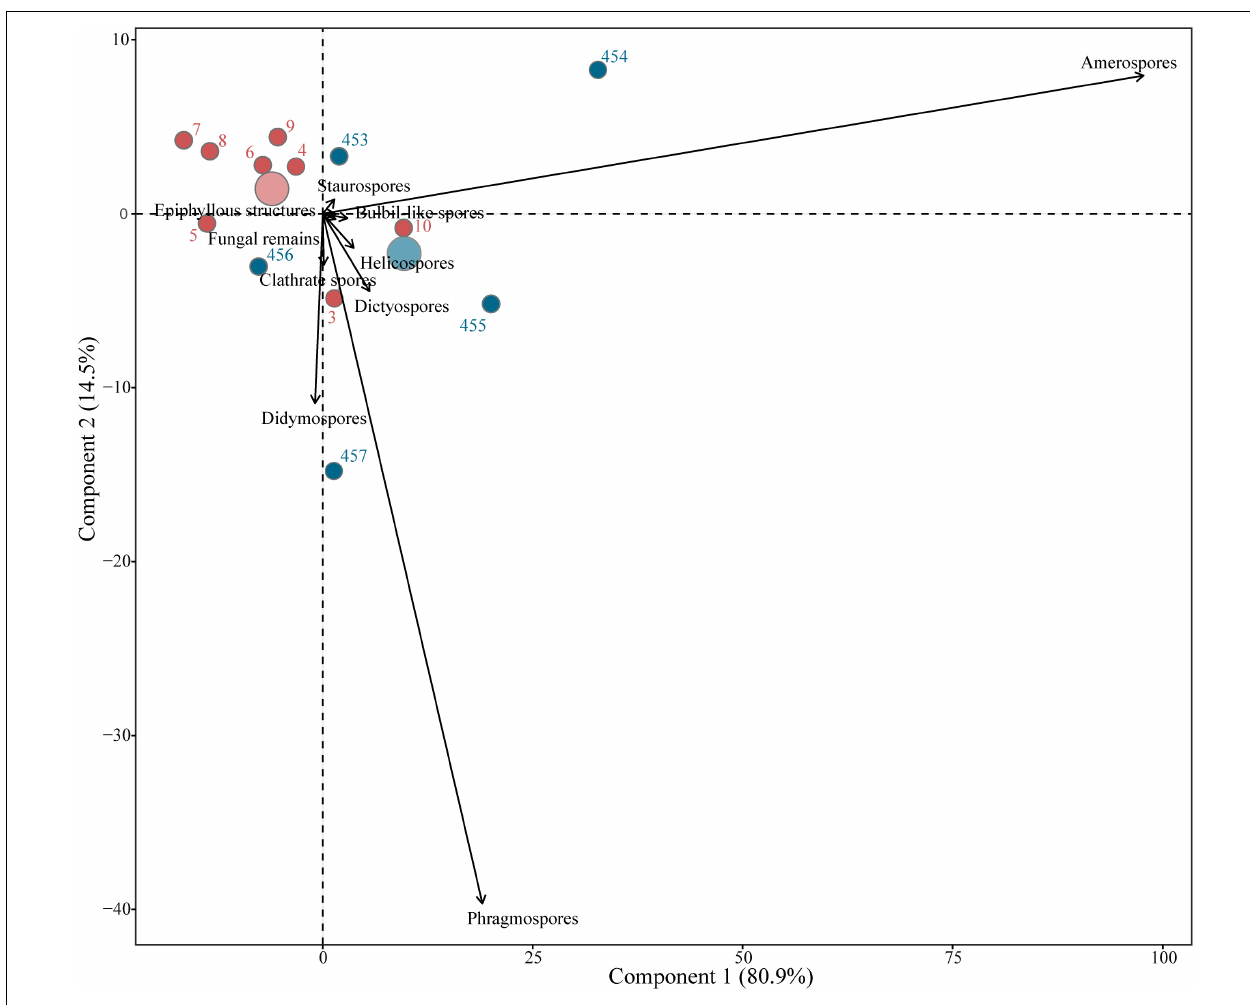
FIGURE 8 | Principal component analysis (PCA), including all morphological groups, compares the variation between and within samples from Thailand and Slovakia. Big circles indicate the midpoint of each group of samples, separating Thailand (blue) and Slovakia (red).